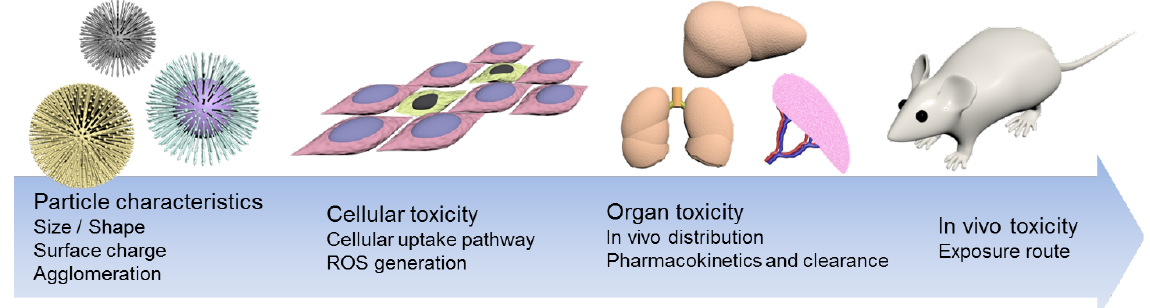
Figure 2. Schematic drawing of nanoparticle induced cytotoxicity. Intrinsic features